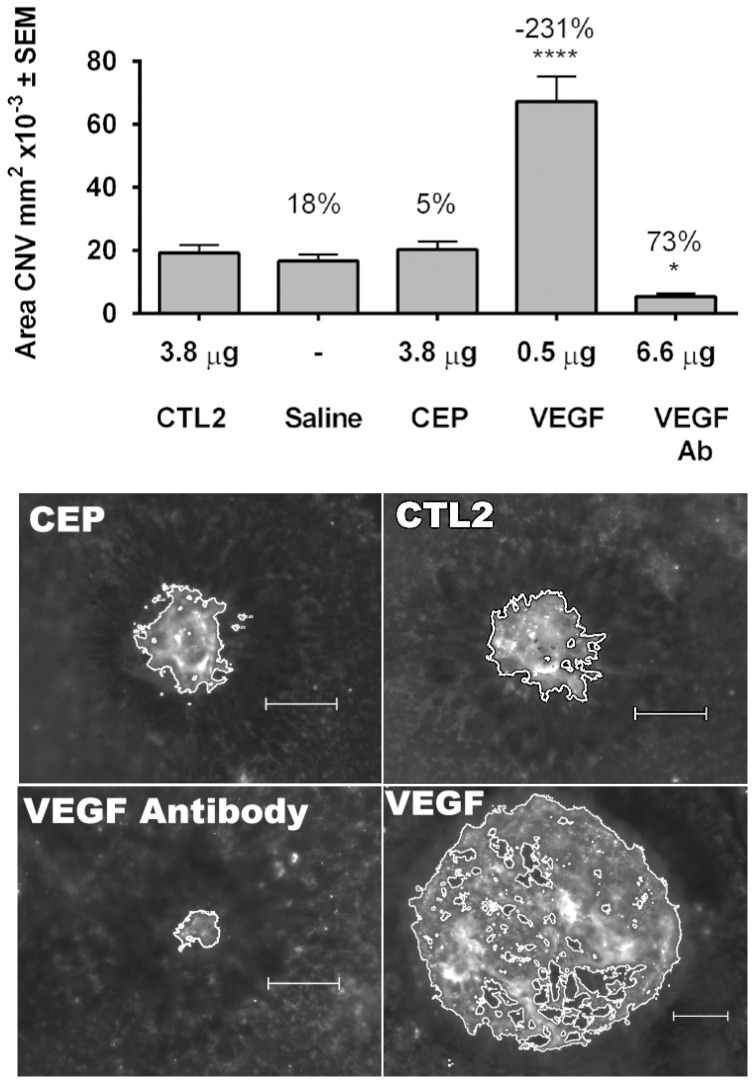
Mouse Laser-Induced CNV Assay.(A) Subretinal injection of MSA-CEP does not increase CNV area compared to mice injected with saline or MSA-CTL2. Bar graph shows mean area of CNV +/− SEM from first experiment evaluating the effect of subretinal injection of saline, 0.5 µg of rhVEGF165, 3.8 µg of MSA-CTL2, 3.8 µg of MSA-CEP, or 6.6 µg of 4G3 (an anti-mVEGF antibody) on laser-induced CNV in C57BL/6J mice. The number above each bar is the percentage inhibition relative to average CNV area in mice injected with MSA-CTL2. Subretinal injection of VEGF increases CNV area and subretinal injection of an anti-mVEGF antibody inhibits CNV area. * p<0.05, **** p<0.0001 by ANOVA with a Dunnett’s post hoc analysis. (B) Representative fluorescent images of CNV lesions 7 days after laser from mice injected in the subretinal space with MSA-CEP, MSA-CTL2, VEGF or a VEGF Antibody as described above. Scale bar = 100 microns. CTL2, MSA-CTL2; CEP, MSA-CEP.